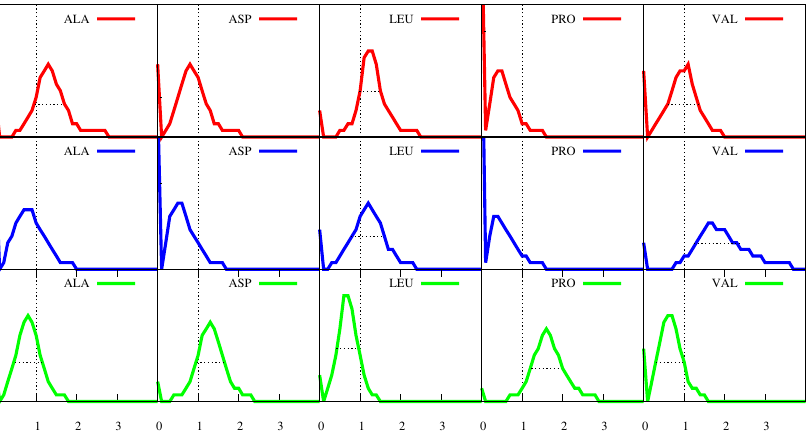
Figure 4. Distributions/histograms for a few of the ratios R ( a , s , p ) (cf. Equation (10)), where the amino acid a is specified at the top of each plot and where red is for s = α -helix, blue is for s = β - sheets and green is for s = loops. The variable R ( a , s , p ) (the x-coordinate) runs from zero to four, the scale of the ordinates is the same in all plots and all histograms are normalised. The vertical dotted line marks the value R ( a , s , p ) = 1, when the actual number of amino acids a in secondary structure s is equal to what is expected in the absence of any correlation between a and s . The horizontal dotted lines are the FWHM of the distributions (see